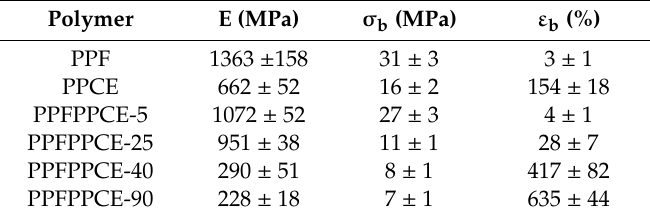
Table 3. Mechanical characterization data of PPF, PPCE, and PPFPPCE-t copolymers. Polymer